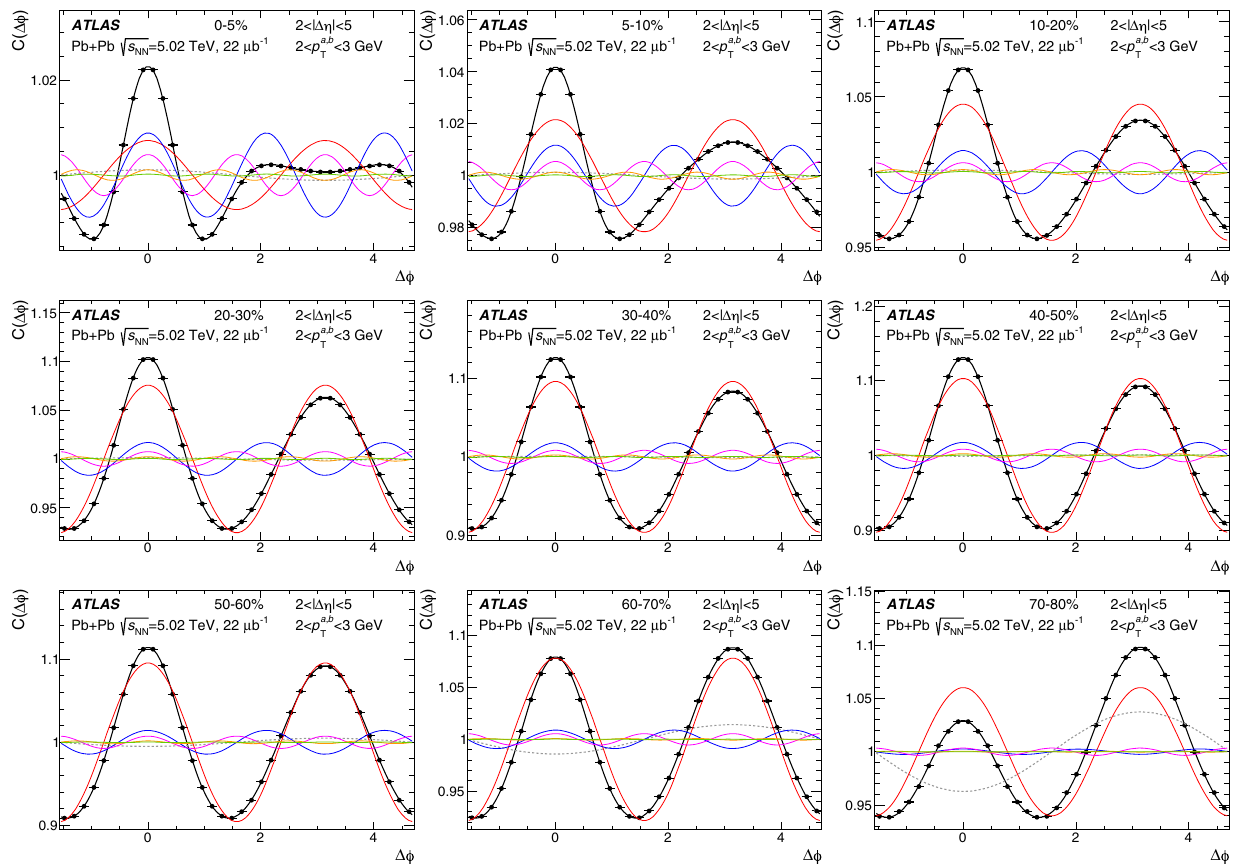
Fig. 3 One-dimensional two-particle correlation functions C ((cid:11)φ) in ( v 2 , 2 -red, v 3 , 3 -blue, v 4 , 4 -magenta, v 5 , 5 -orange, v 6 , 6 -green), and can be < 3 GeV (points). The identified by the number of peaks that they have. Each panel corre- 5.02 TeV Pb+Pb collisions for 2 < p a , b T sponds to a different centrality class. The y -axis range for the different solid-black line indicates a fit to Eq.(2) containing harmonics v n , n up panels is to n = 6. The dashed grey line shows the contribution of the v 1 , 1 . The contributions of the v 2 , 2 – v 6 , 6 are indicated by thecoloured lines